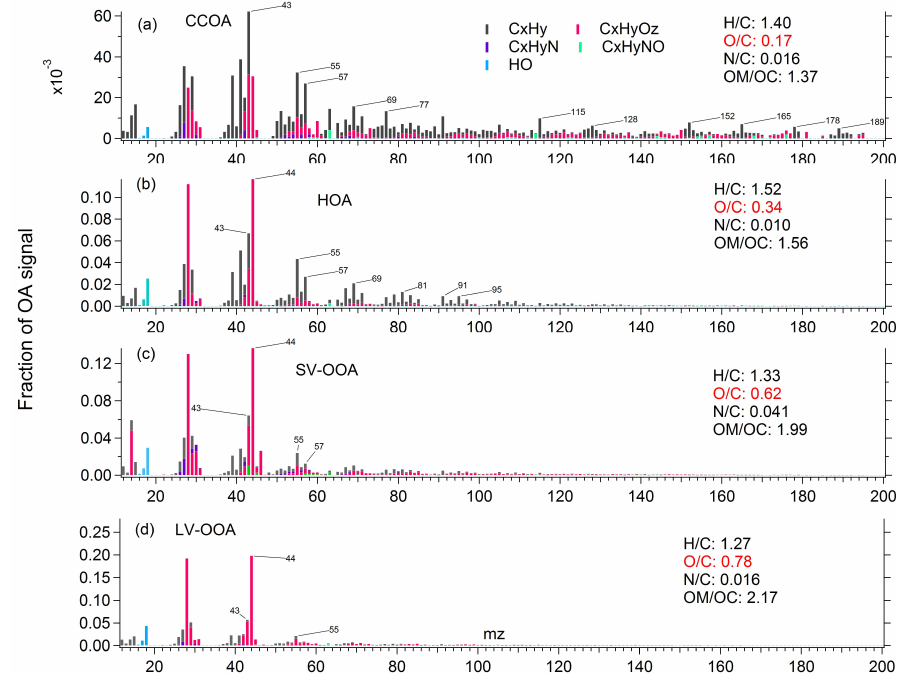
Fig. 3. High resolution mass spectra of OA components (a) coal combustion OA (CCOA); (b) hydrocarbon-like OA (HOA); (c) semi-volatile oxygenated OA (SV-OOA); (d) low-volatile oxygenated OA (LV-OOA). The elemental ratios and OM/OC ratios of each component are also shown in the